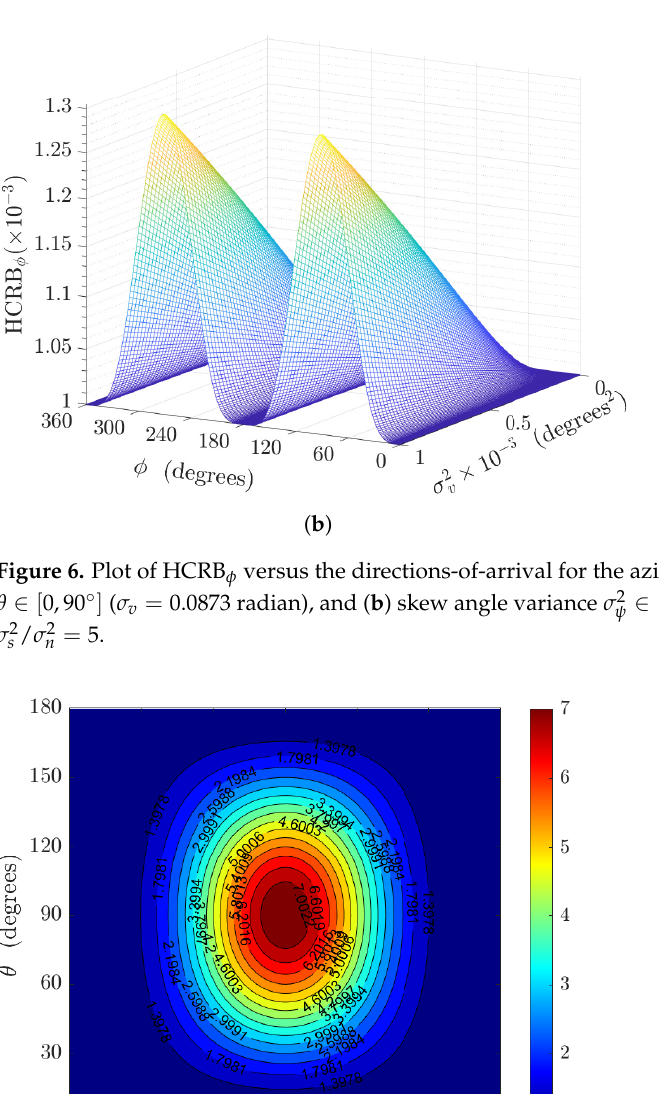
Figure 7. Plot of the performance ratio r φ versus the polar angle and azimuth angle for σ ψ =